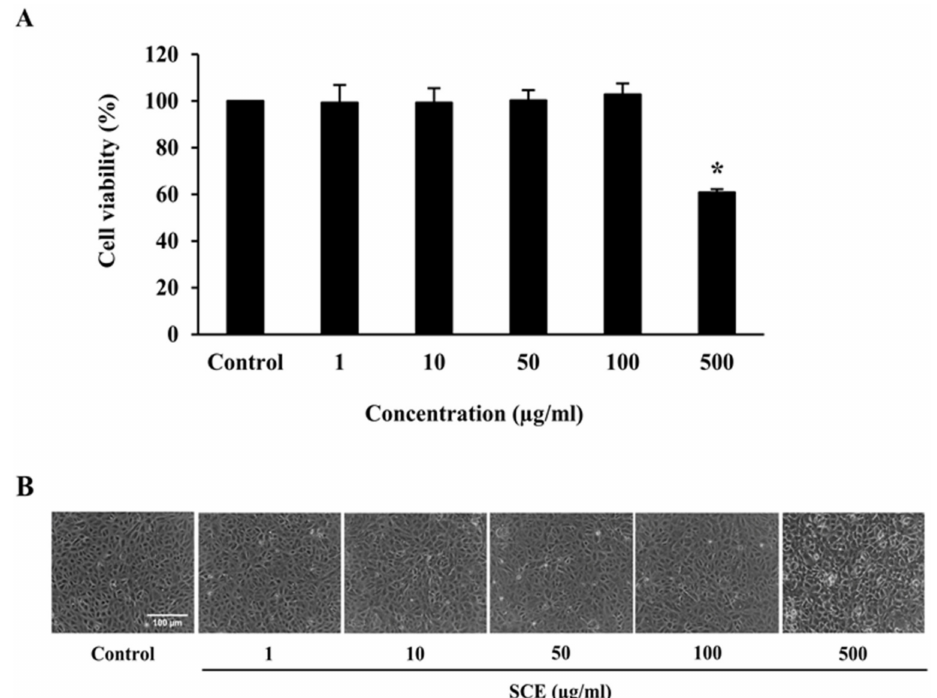
Figure 2. Effect of SCE on the viability of ARPE-19 cells. ( A ) ARPE-19 cells were incubated with SCE from 1 to 500 µ g/mL in serum-free medium for 24 h, after which the viability of cells was evaluated using an MTT assay. A concentration of 0.5% DMSO in serum-free medium was used as the control group. Graphs represent average cell viability (mean ± SD; n = 3). * indicates groups are significantly different from the control group ( p < 0.05). ( B ) Cell morphology of treated ARPE-19 was observed using phase-contrast microscopy. The scale bar represents 100 µ m, 10 × magnification.